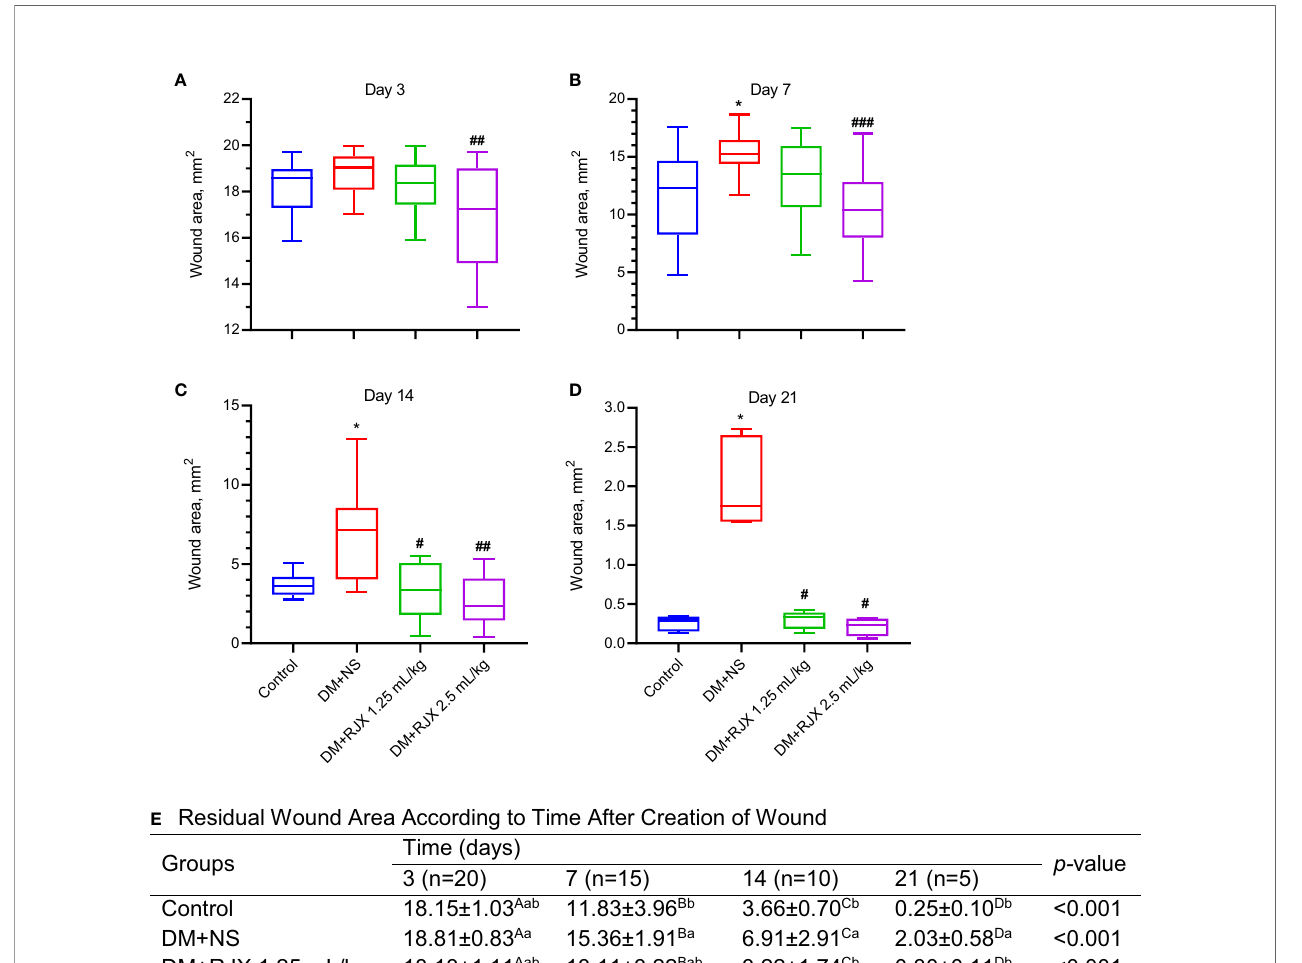
FIGURE 1 | (A – D) RJX Accelerates Cutaneous Wound Healing in Diabetic, Obese Rats. (A) The Effects of Rejuveinix (RJX) on Wound Closure in Healing Diabetic Wounds. Wistar albino rats were treated with i.p injections of RJX (1.25 mL/kg and/or 2.5 mL/kg), or vehicle (NS). Except for untreated control rats (Control), each rat was fed a high-fat diet (HFD) for four weeks and injected a single dose of streptozotocin (STZ, 45 mg/kg i.p.) to induce diabetes (DM). At the end of 4 weeks, an experimental wound with a diameter of 5 mm (initial wound areas= 19.625 mm 2 ) was created in all rats. The closure of the wound area was measured by digital camera until day 21. The depicted wound area data represent the median and min-max. Statistical signi fi cance between groups is shown by *p<0.05 compared to the control group, and # p<0.05; ## p<0.01 compared to the DM+NS group. ANOVA and Tukey ’ s post-hoc or Welch-ANOVA and Tamhane T2 ’ s post-hoc test were used for comparing the results among different treatment groups. (E) Residual Wound Area in Diabetic Rats Treated with RJX vs NS. A,B,C,D Means in a row with different superscripts are statistically different (p<0.05). a,b Means in a column with different superscripts are statistically different (p<0.05). ANOVA and Tukey ’ s post-hoc or Welch-ANOVA and Tamhane T2 ’ s post-hoc test were used for comparing the results among different treatment groups or different times. ### p<0.001 compared to the DM+NS